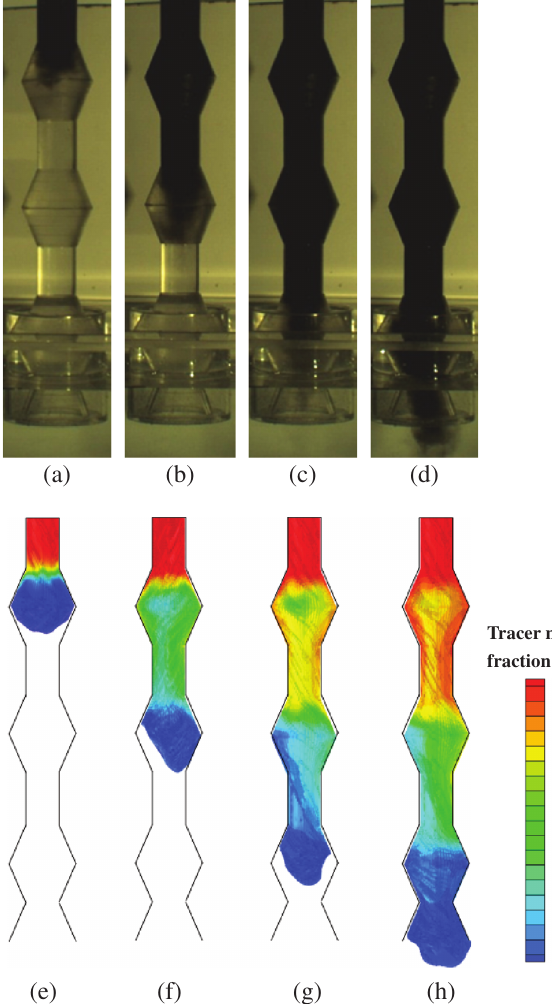
Figure 3: Tracer dispersion profiles at different time: (a) 0.104s, (b) 0.304s, (c) 0.477s, and (d) 0.598s in the physical modelling; (e) 0.100s, (f) 0.300s, (g) 0.470s and (h) 0.610s in the LES